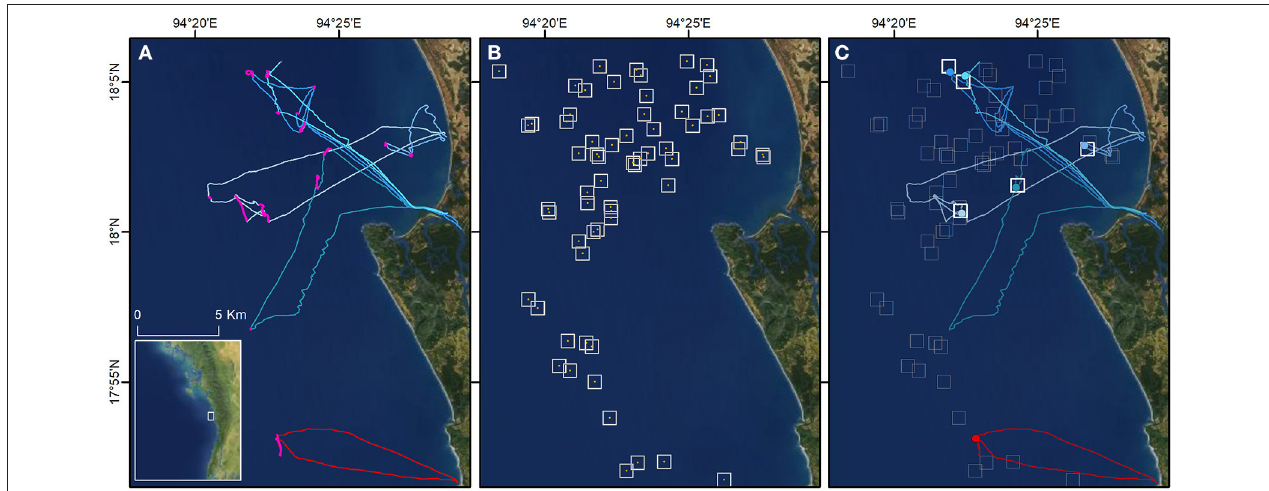
FIGURE 2 | Visual example of one nights GPS to VBD matching. (A) Five successfully matched GPS tracked fishing trips (blue lines) and one unmatched trip (red line) with predicted behavioral fishing states highlighted (pink lines). (B) VBD records (yellow points) with the pixel footprint (742m) overlaid (white square). (C) The GPS location (points) of each vessel at the time of closest satellite